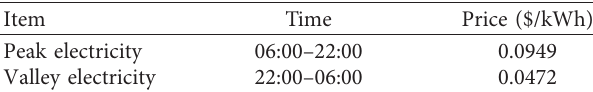
Table 4: Different stages of electricity for residential customers [31].